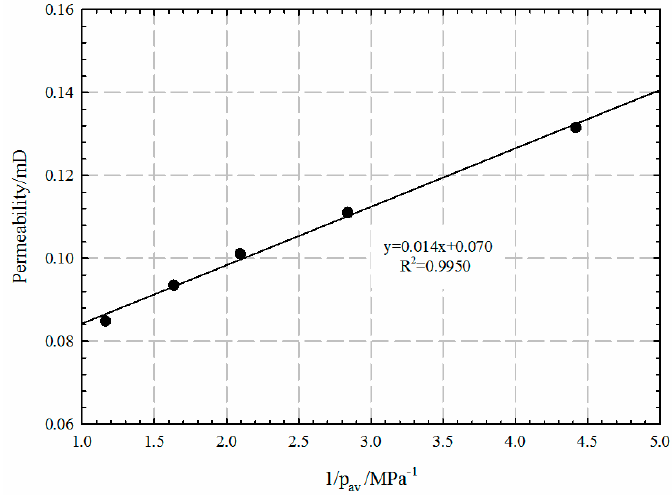
Figure 3. Measured gas permeability versus inverse of pressure for Sample #8.